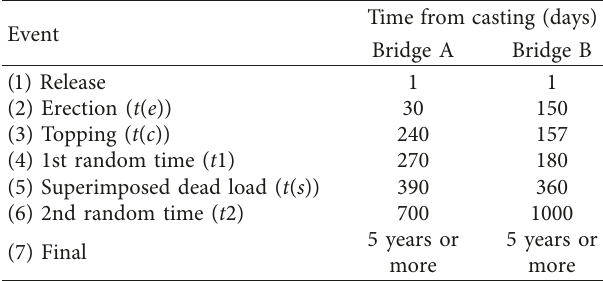
Figure 3: Cross-sectional details of bridges (a) A and (b) B. Table 6: Construction history of bridges A and B.